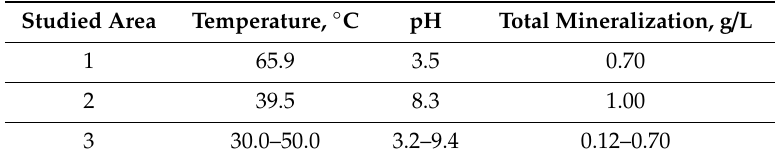
Table 1. Physical and chemical characteristics of the hot springs studied [20,21,26,27].